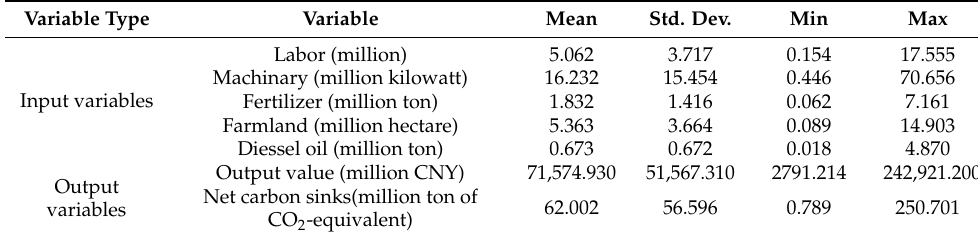
Table 1. Descriptive statistics on agricultural input and output